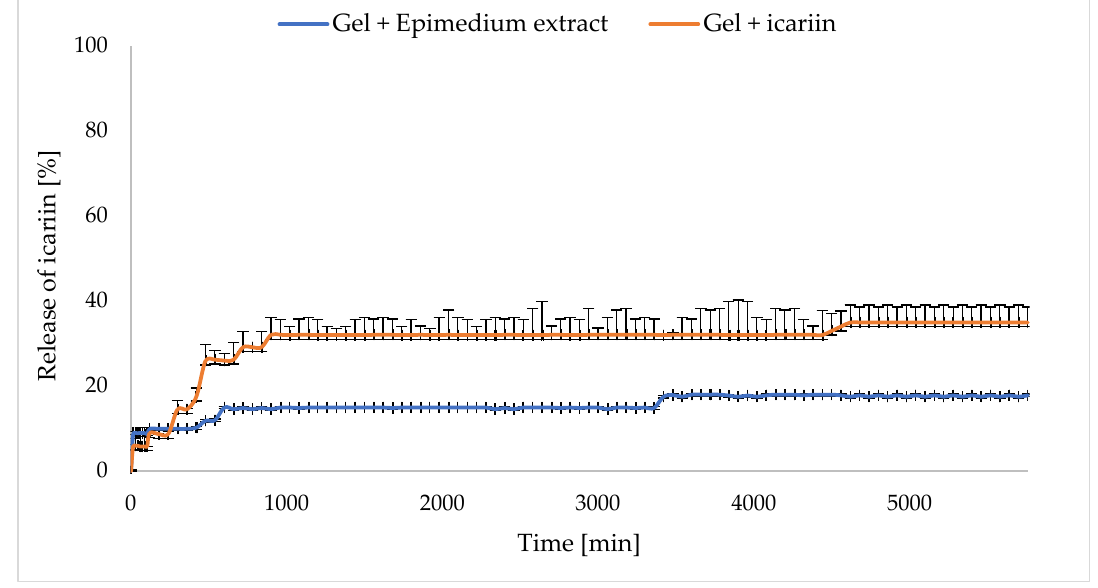
Figure 2. Release of icariin from gel formulation.